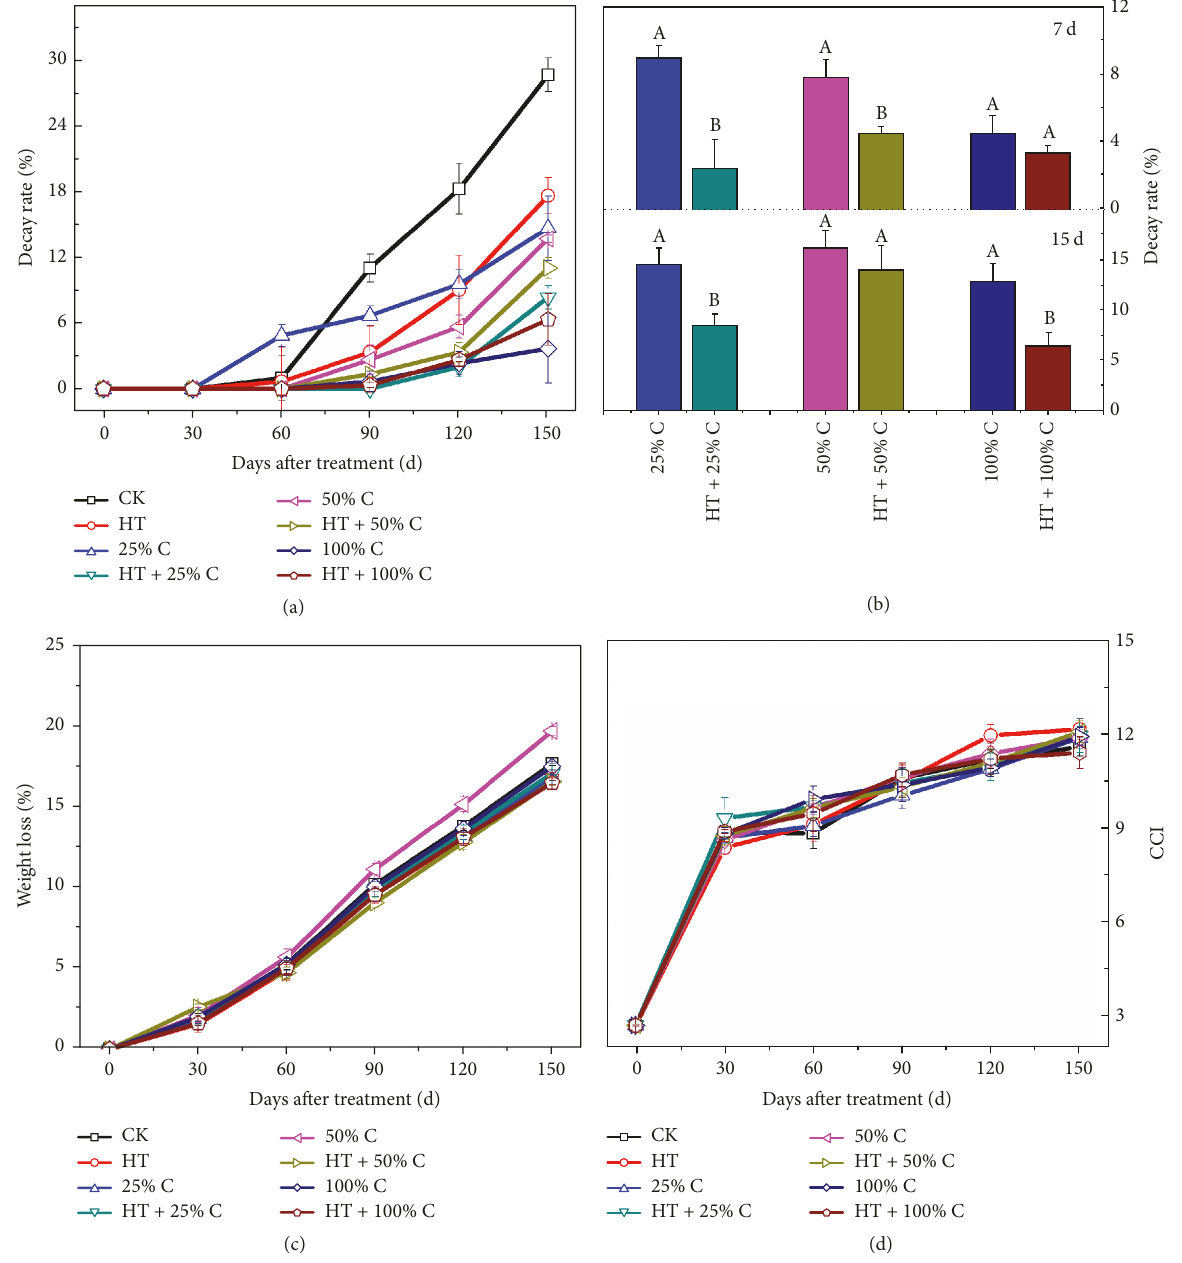
Figure 1: Effects of different combined heat and preservative treatments on the decay rate (a), shelf life (b), weight loss (c), and CCI (d) of Ponkan fruit during storage. “C” represents the concentration of preservative used in production. The error bars represent the standard errors. Letters on columns represent significant differences at the 0.05